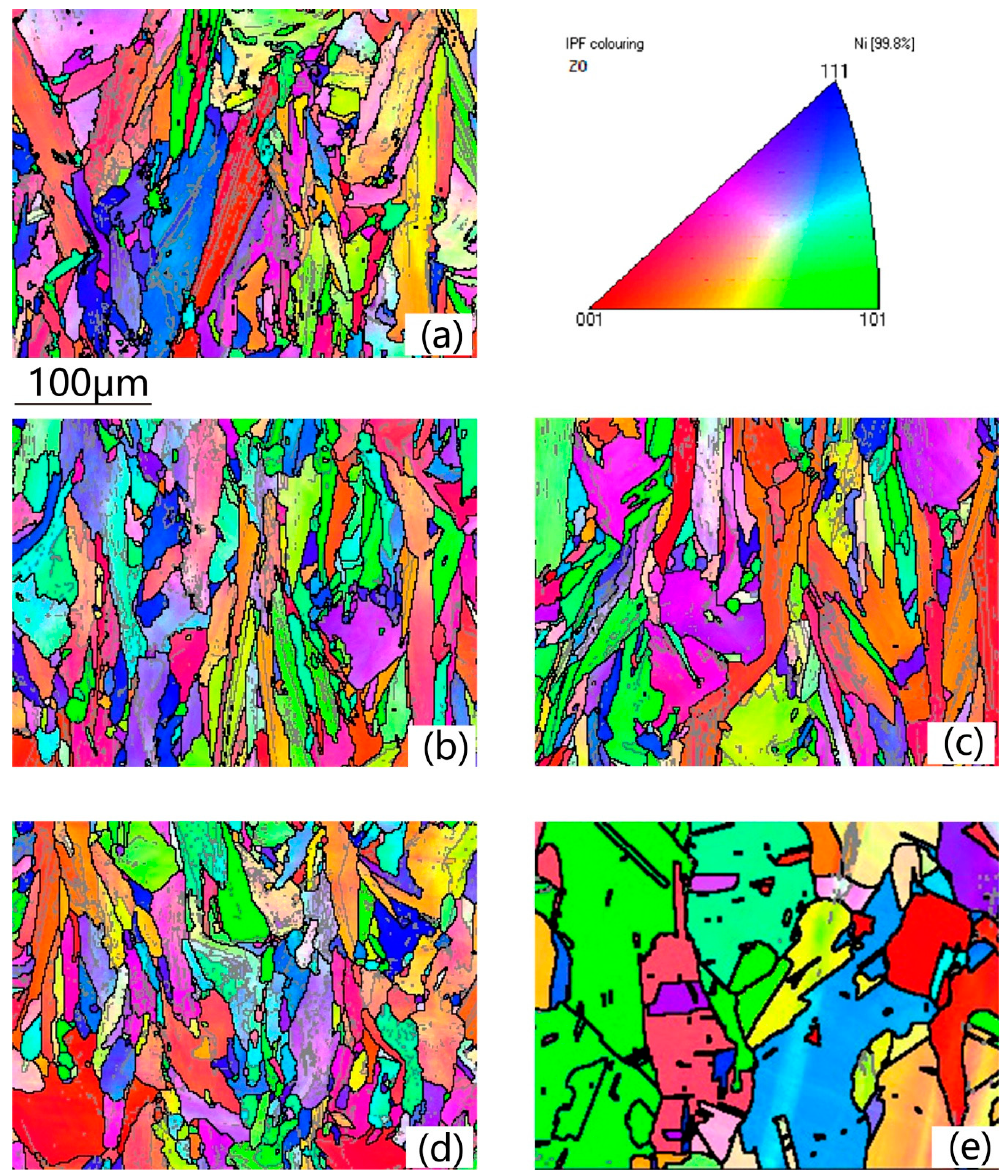
Figure 3. EBSD inverse-pole figure of the samples: ( a ) As-deposited condition, ( b ) 980 °C/h, ( c ) 1030 ◦ C / h, ( e ) 1130 ◦ C / °C/h, ( d ) 1080 °C/h, ( e ) 1130 °C/h. ( d ) 1080